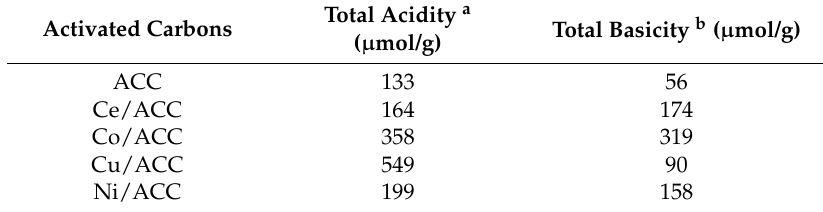
Table 3. Total acidity and total basicity of catalysts.